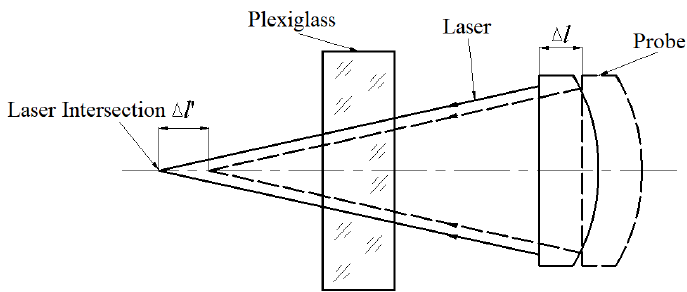
Figure 4. Data calibration principle.